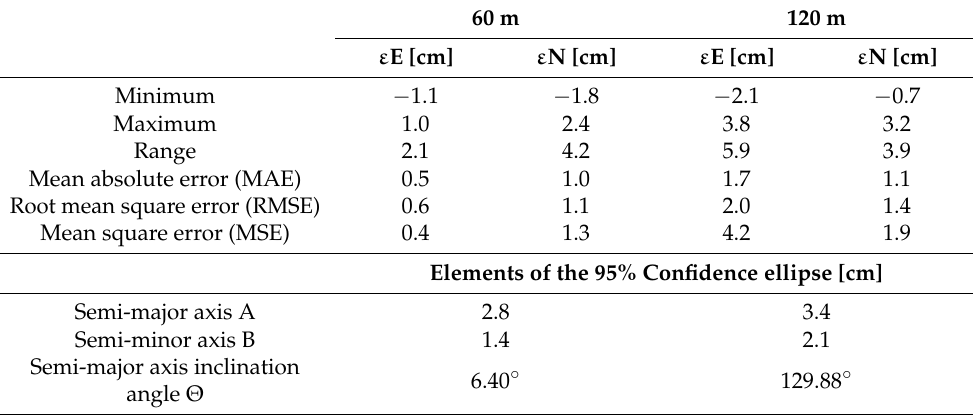
Table 7. UAS senseFly eBee Plus—achieved data quality with the use of GCPs.